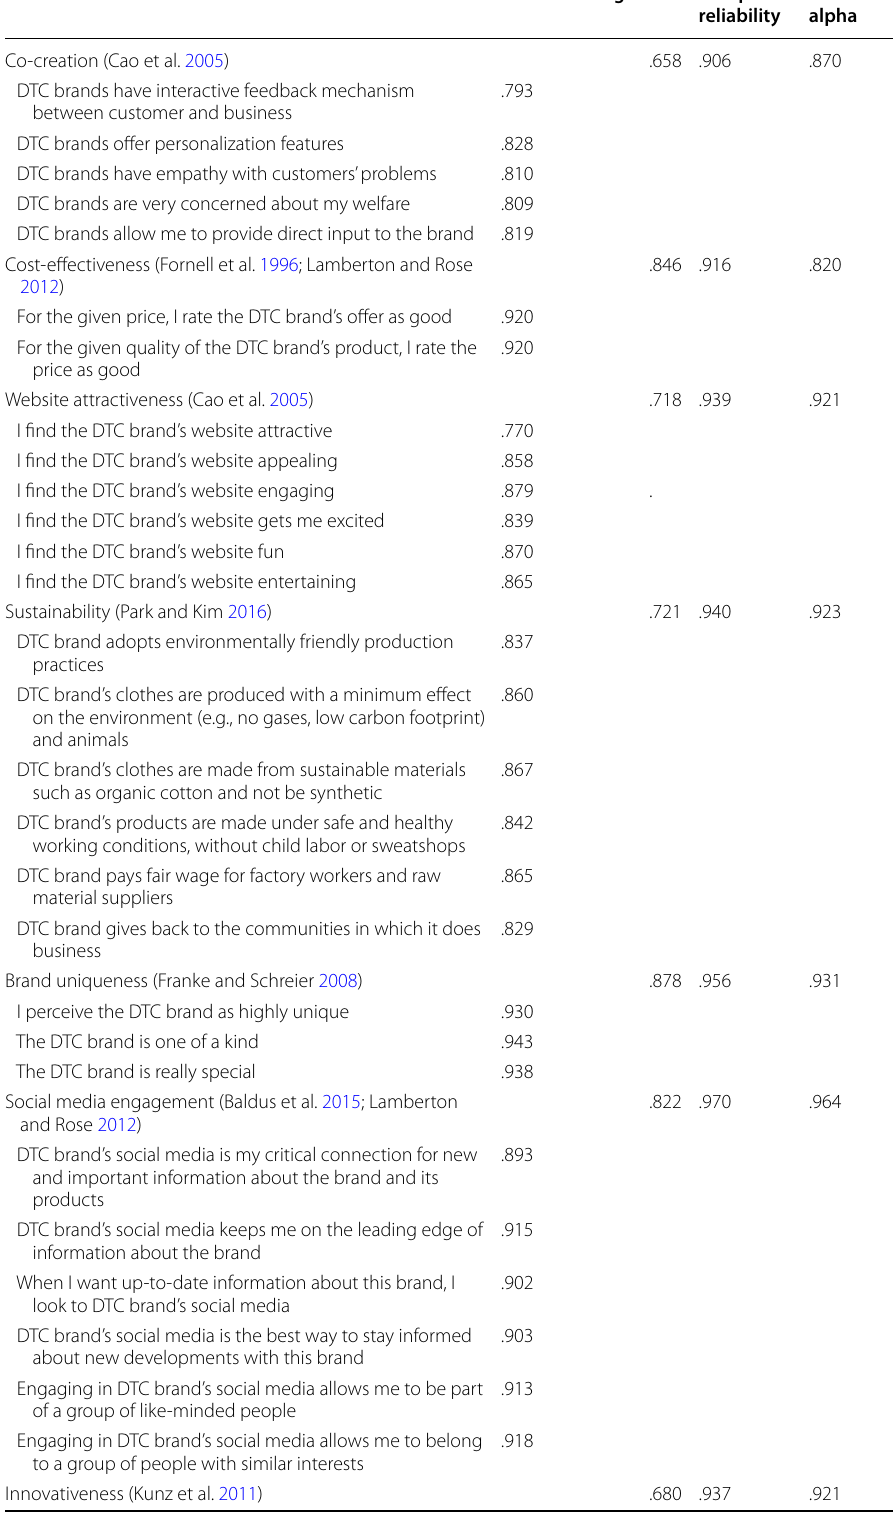
Table 3 Measurement items and exploratory factor analysis